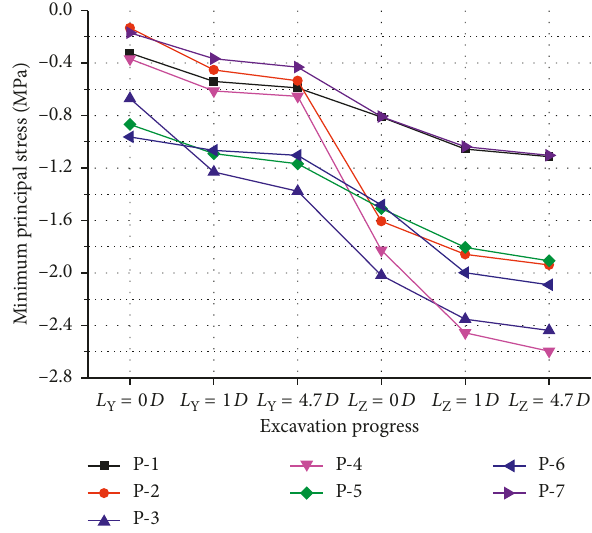
Figure 17: Variation of stresses in middle partition